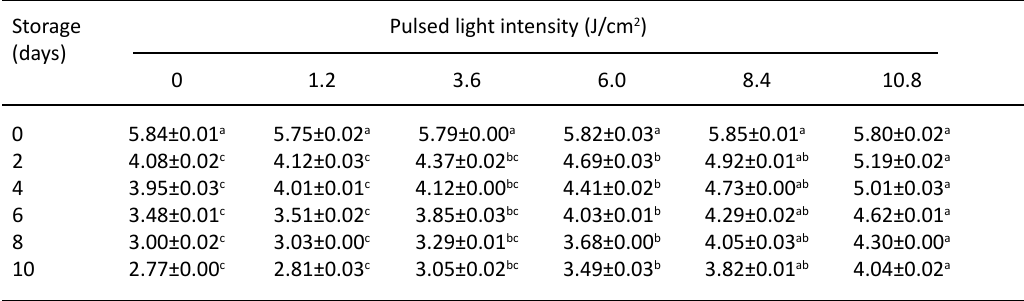
Table 4. Textural hardness (N) of Chinese kale affected by pulsed light intensity (J/cm 2 ) Storage